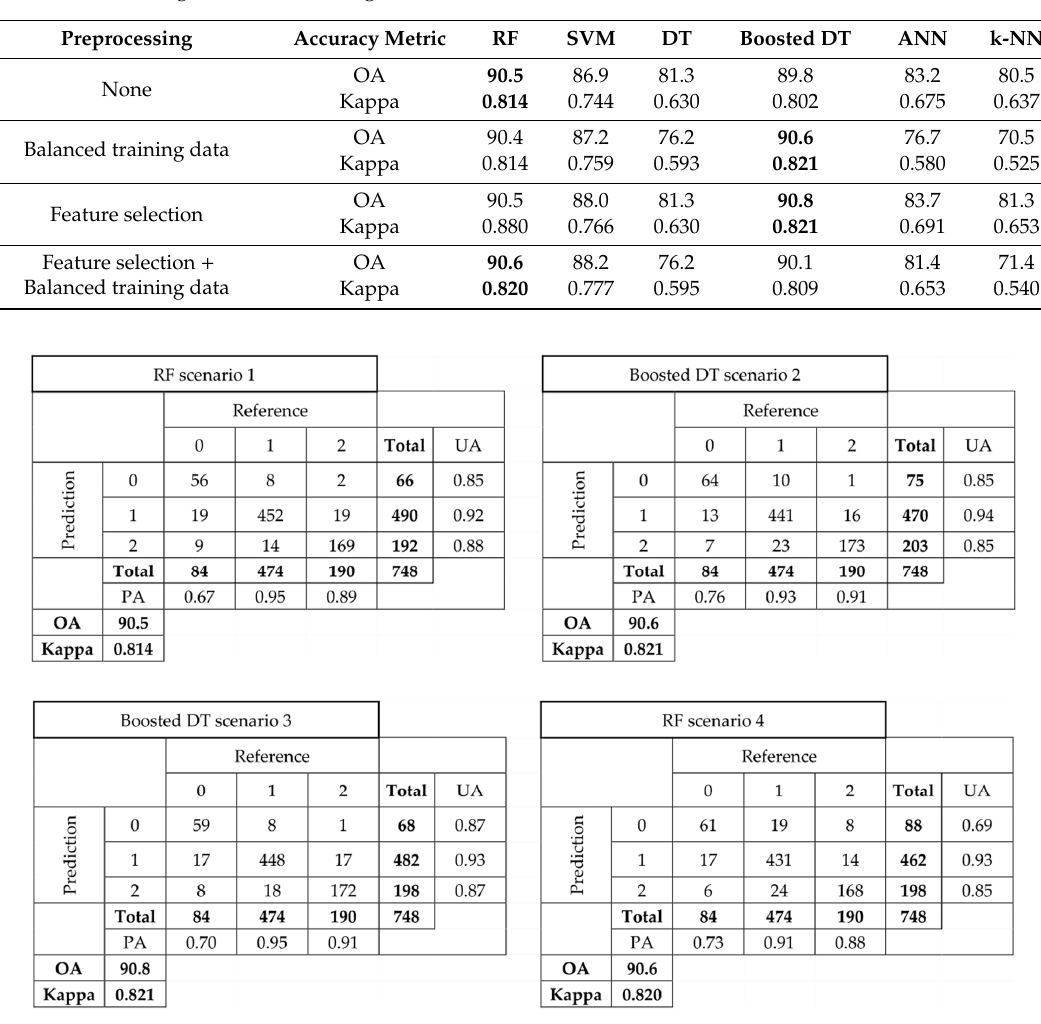
Figure 13. Classification model generated using Boosted DT as classifier and by applying a recursive feature selection process (scenario 3), which maximized the accuracies on the validation set as shown in Table 8. (a) The plot reports the Kappa statistic obtained in cross-validation in function of the number of variables/features used to build the model. A number of features equal to 126 maximized the Kappa statistic, which is highlighted with the filled circle. (b) The feature relevance score. Overall, larger weights were given to NDVI features (mainly in the June–October time frame) rather than satellite precipitation data.